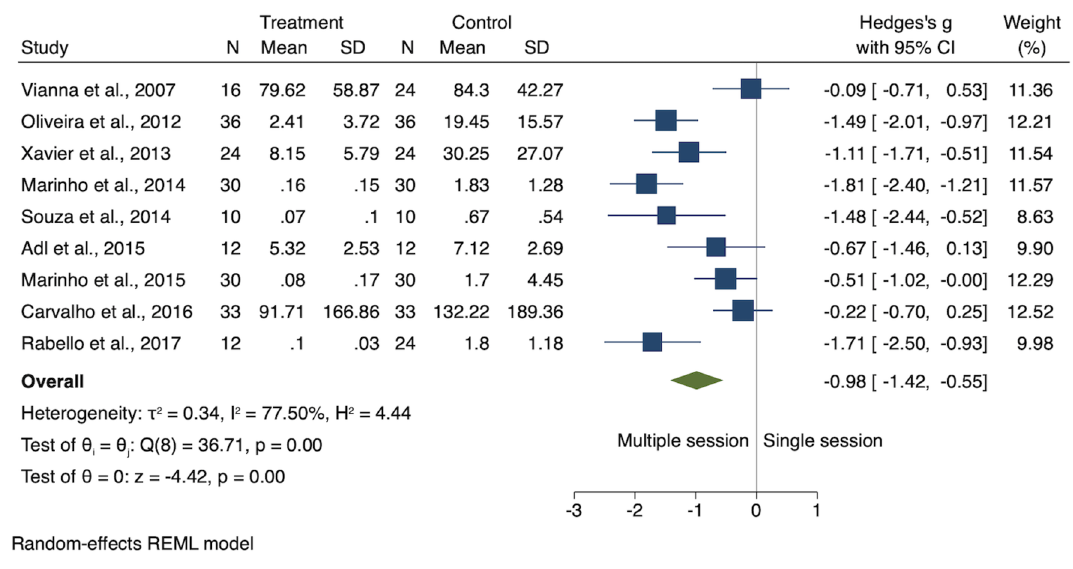
Figure 4. Forest plot for the endotoxin levels for single and multiple-session using calcium hydroxide medication irrespective period of time of